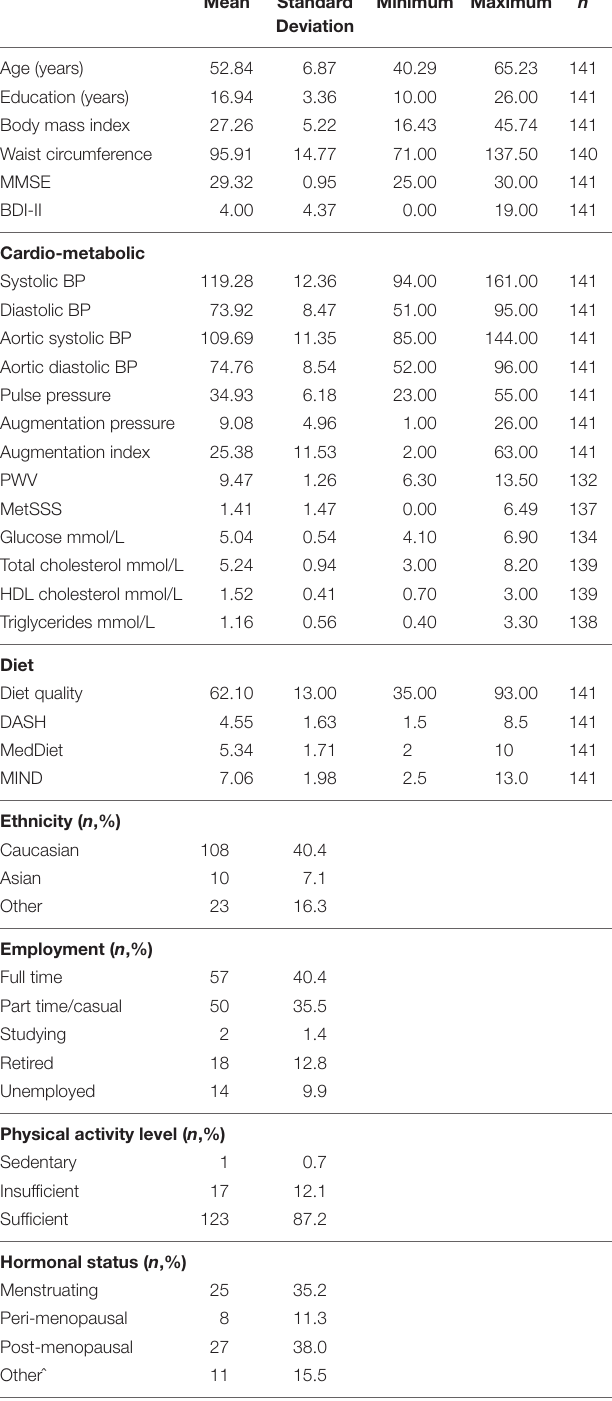
TABLE 2 | Characterization of the study sample for all